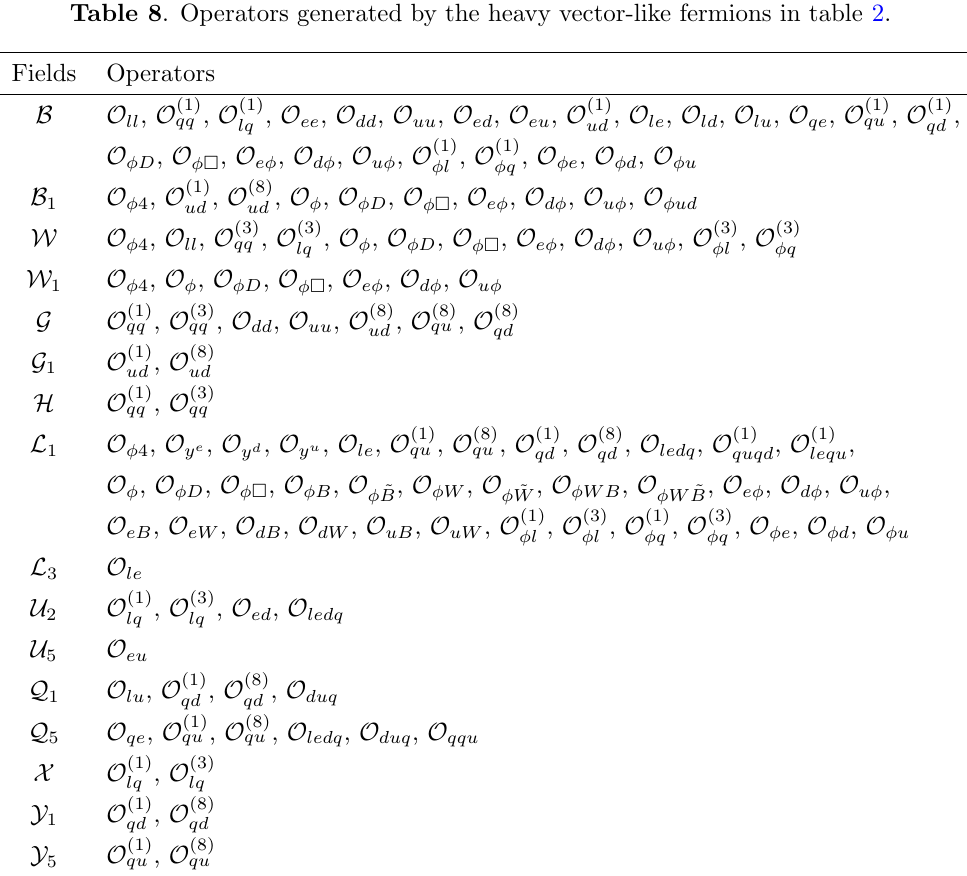
Table 9 . Operators generated by the heavy vector bosons presented in table